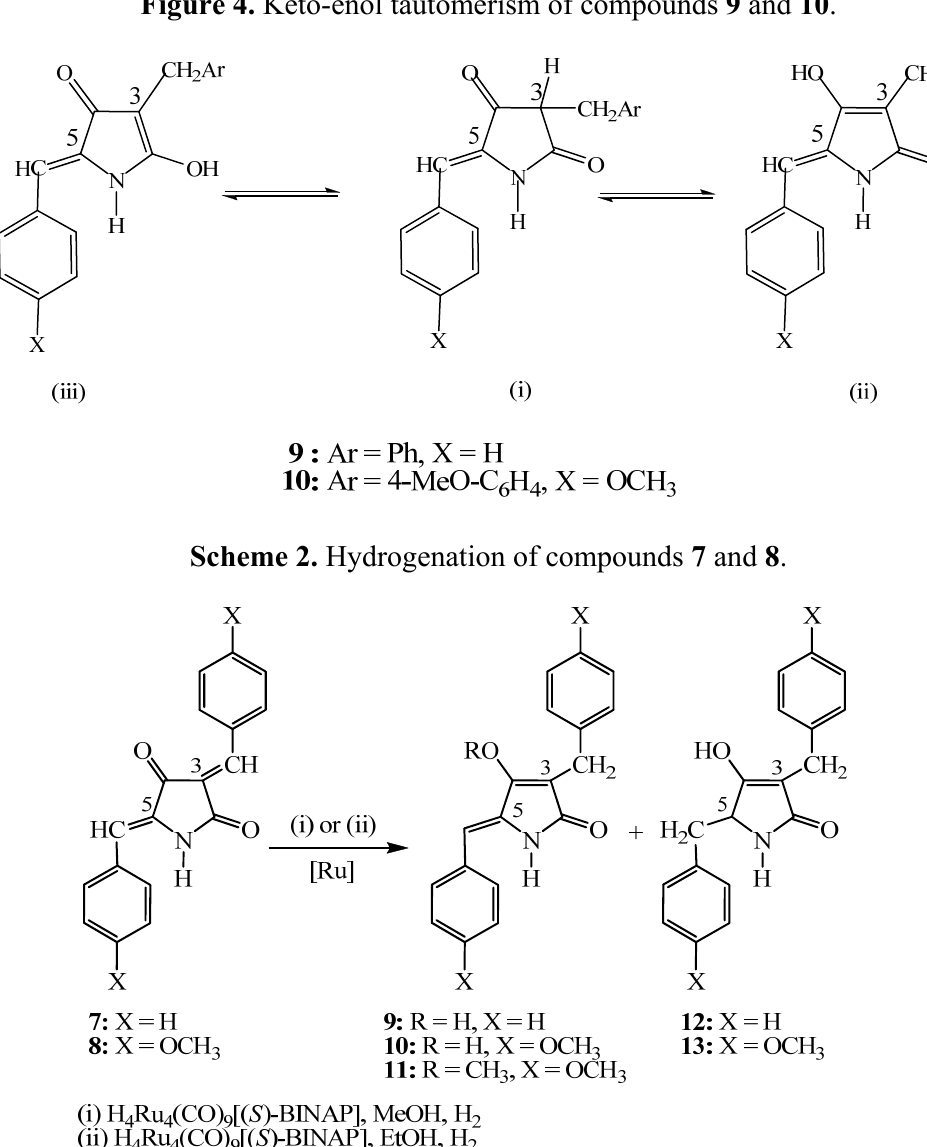
Figure 4. Keto-enol tautomerism of compounds 9 and 10 .